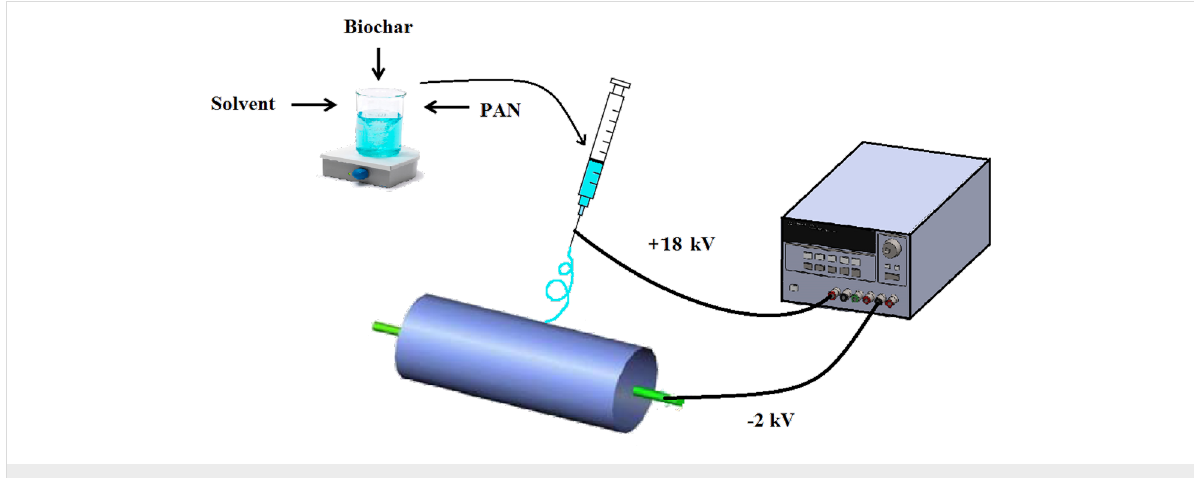
Figure 1: Schematic of the electrospinning